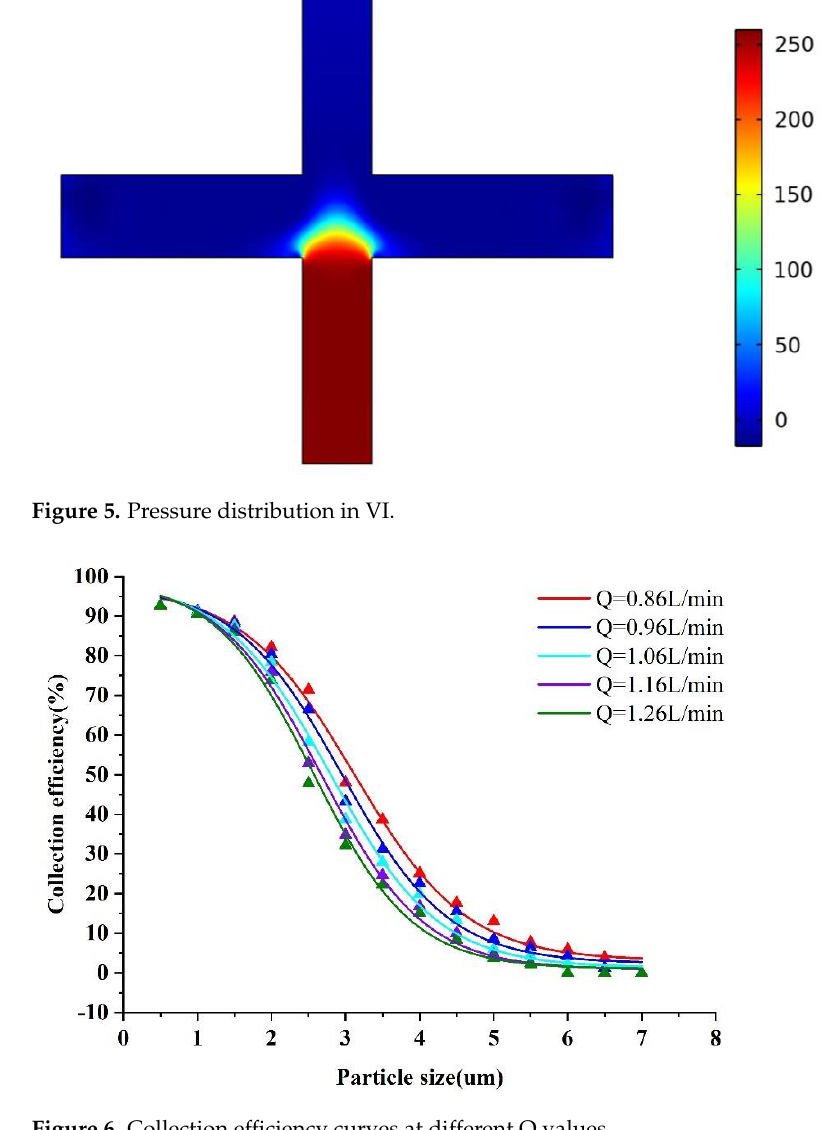
Figure 6. Collection efficiency curves at different Q values.